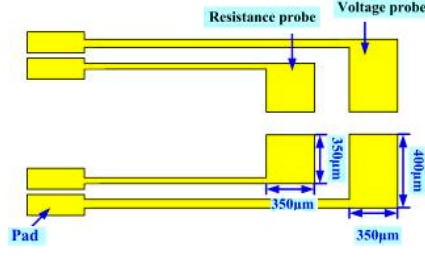
Figure 5. Design of micro current sensor.